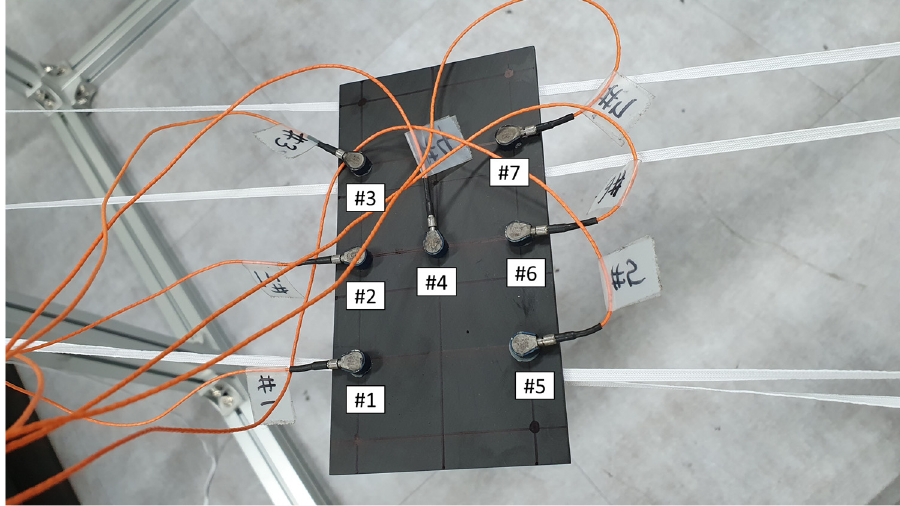
Figure 3. CFRP specimen suspended with a rubber band for an impact modal test [23,24]. Table 1. Measured modal parameters of the CFRP specimen for five different carbon fiber angles [23,24]. Specimen Resonance Frequency (Hz) Modal Damping Ratio (%) Mode